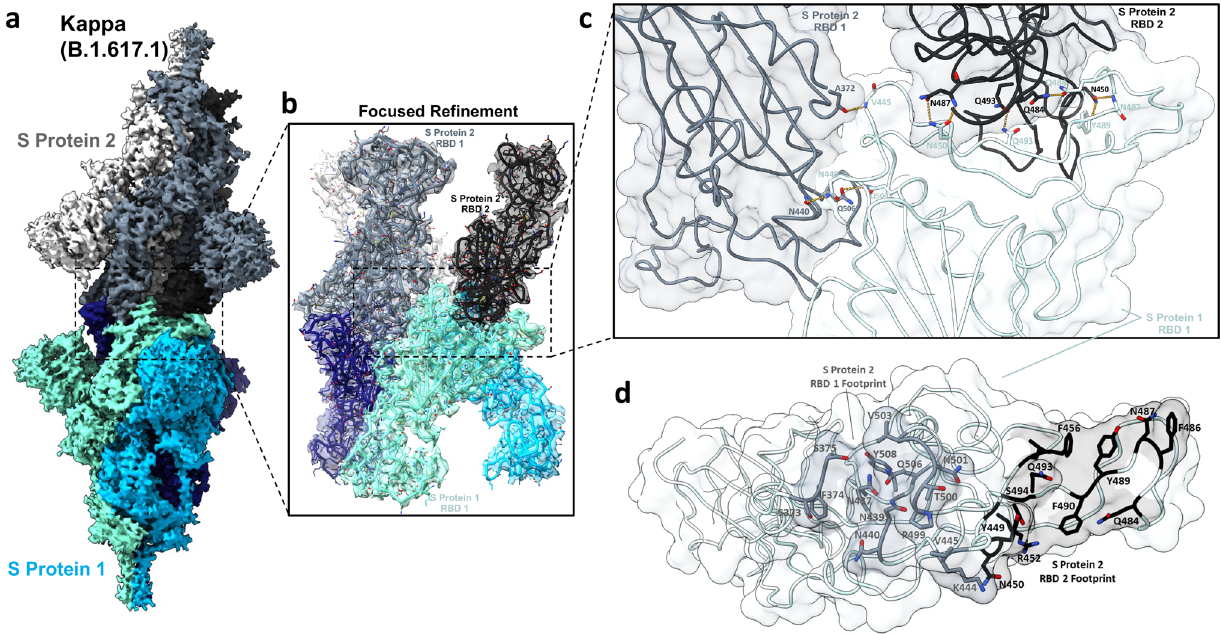
Fig. 4 The Kappa variant S protein exhibits a novel dimer-of-trimers phenotype. a Side view of the global cryo-EM density map of the Kappa variant dimer-of-trimers complex. One trimer (S Protein 1, bottom) is displayed in various shades of blue, and the other trimer in grayscale (S Protein 2, top). b Focus-re fi ned cryo-EM density map and fi tted atomic model at the dimerisation interface. c Detailed view of the molecular interface between two RBDs in the grayscale trimer (top) and a single RBD in the blue shaded trimer (bottom). For amino acids involved in inter-residue hydrogen bonding, the backbone and sidechain atoms are displayed. Hydrogen bonds are indicated by yellow dashed lines. d The top-down view of the region in panel c is shown. The binding footprints of RBD1 and RBD2 are indicated by complementary shading and displaying the sidechain atoms of footprint residues.